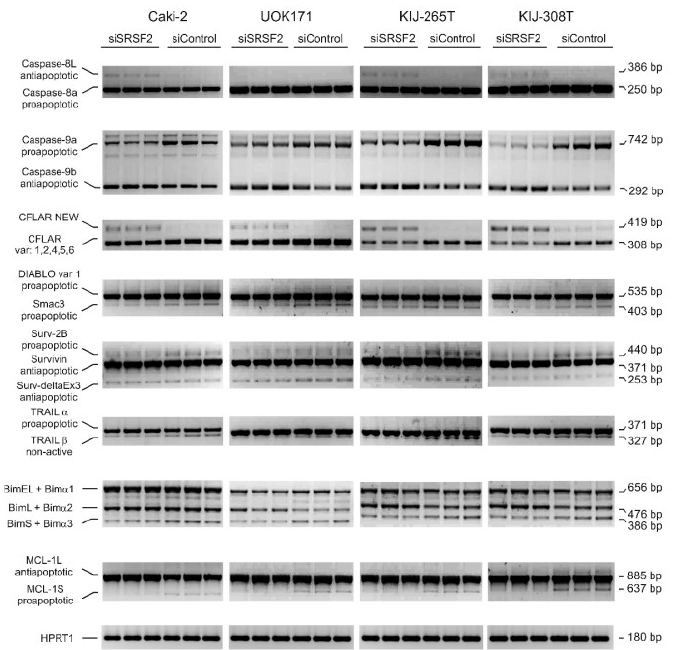
Figure 4. The e ff ect of SRSF2 silencing on splicing patterns of apoptotic genes. Electrophoretic analysis of PCR-amplified splicing variants of apoptotic genes in four renal cancer-derived cell lines